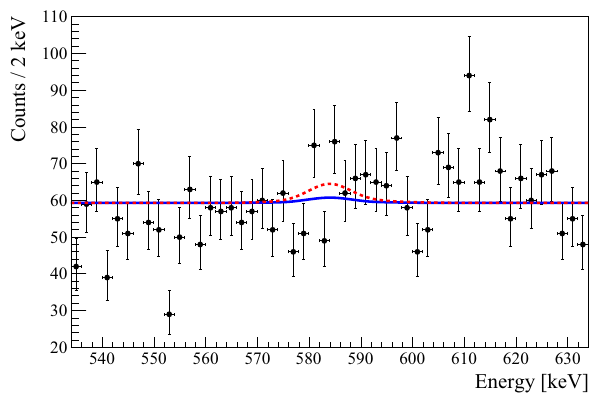
Fig. 6 Zoom of the yellow spectrum reported in Fig. 3 in the energy region of interest for signature E (583.9keV). We fit this spectrum with the signal model over an exponentially decreasing background. Dotted line: a hypothetical signal corresponding to the 90% CI limit set in this work